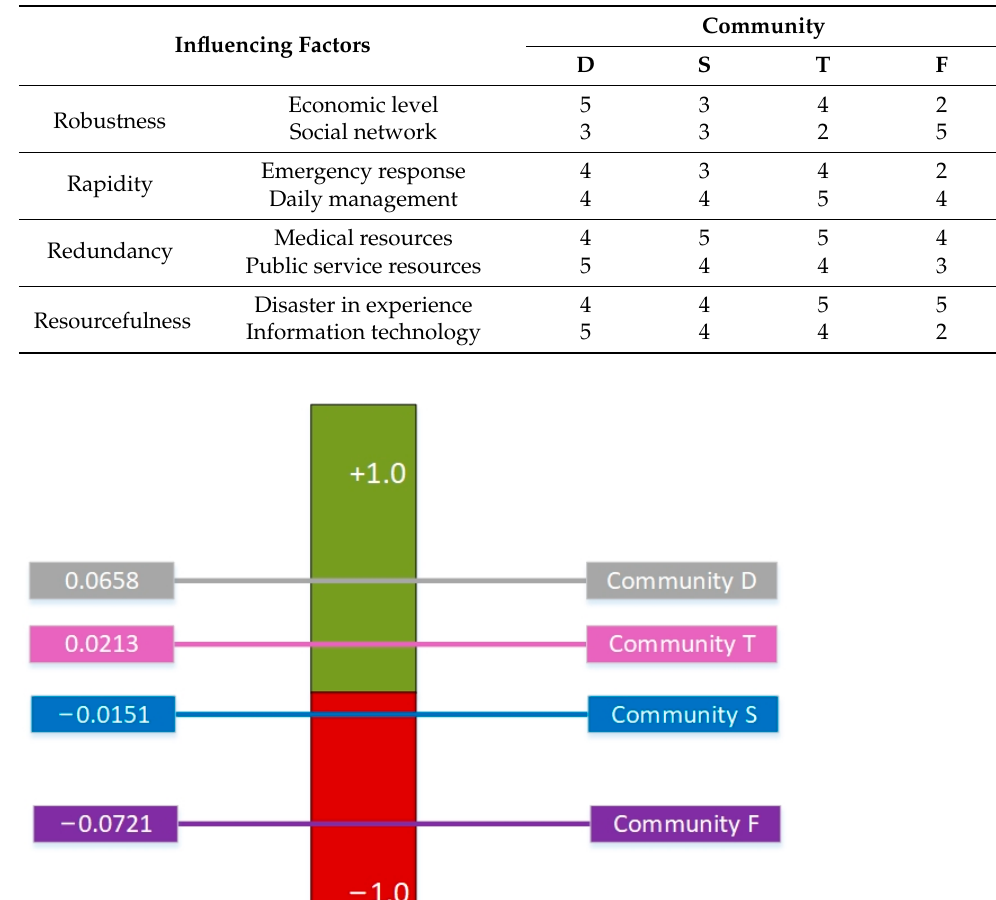
Table 5. Epidemic resilience adapting scoring scale.